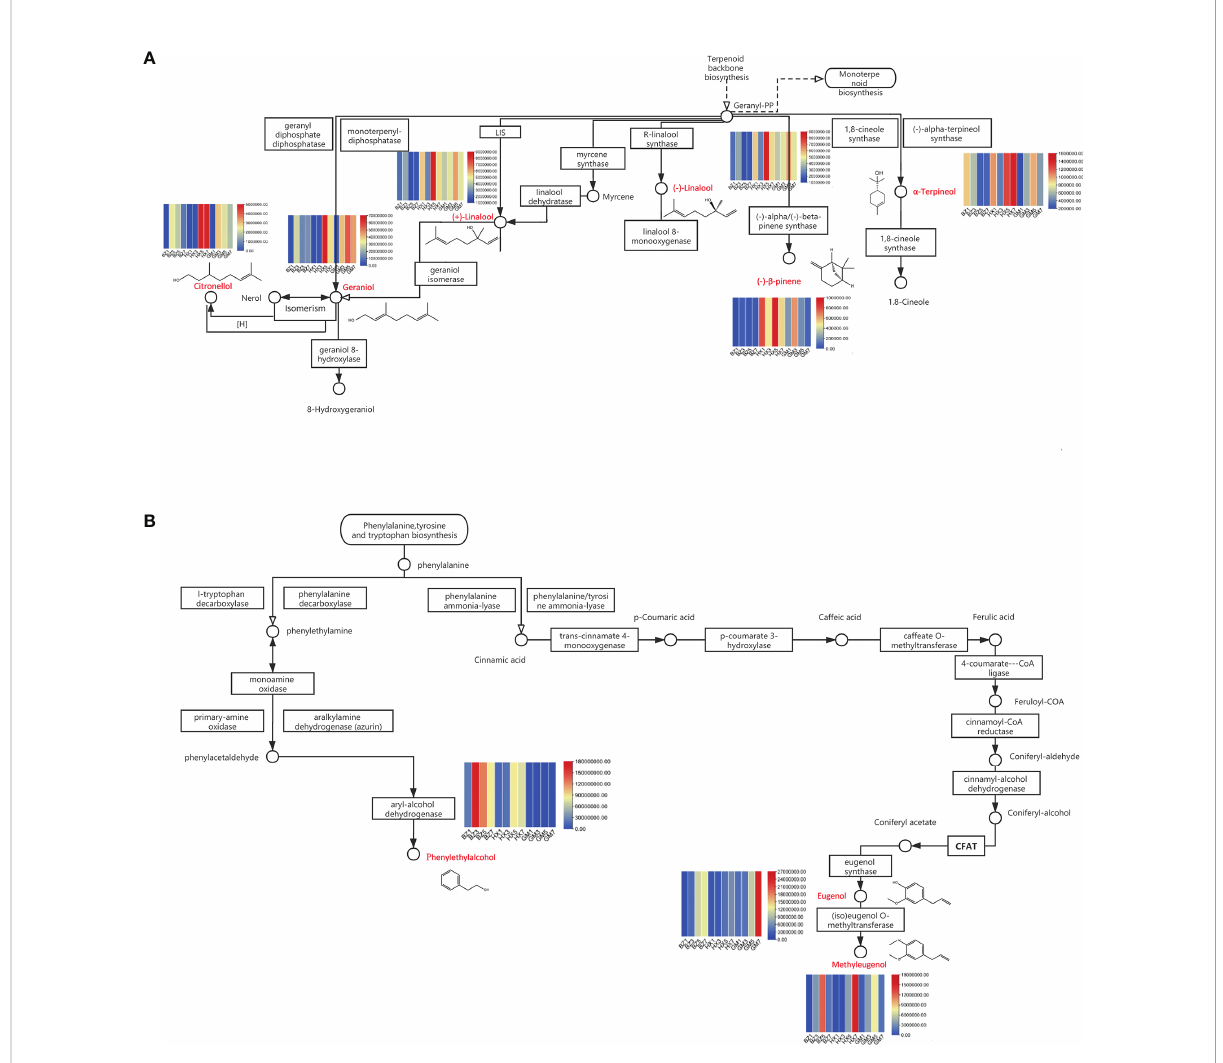
FIGURE 5 Enriched biosynthetic pathways in Rosa rugosa . The patterns in volatile organic compound (VOC) contents over the four fl owering stages for three varieties of R. rugosa are provided above or below the differential metabolites (red font). (A) Monoterpenoid biosynthetic pathway. (B) Phenylalanine, tyrosine, and tryptophan biosynthetic